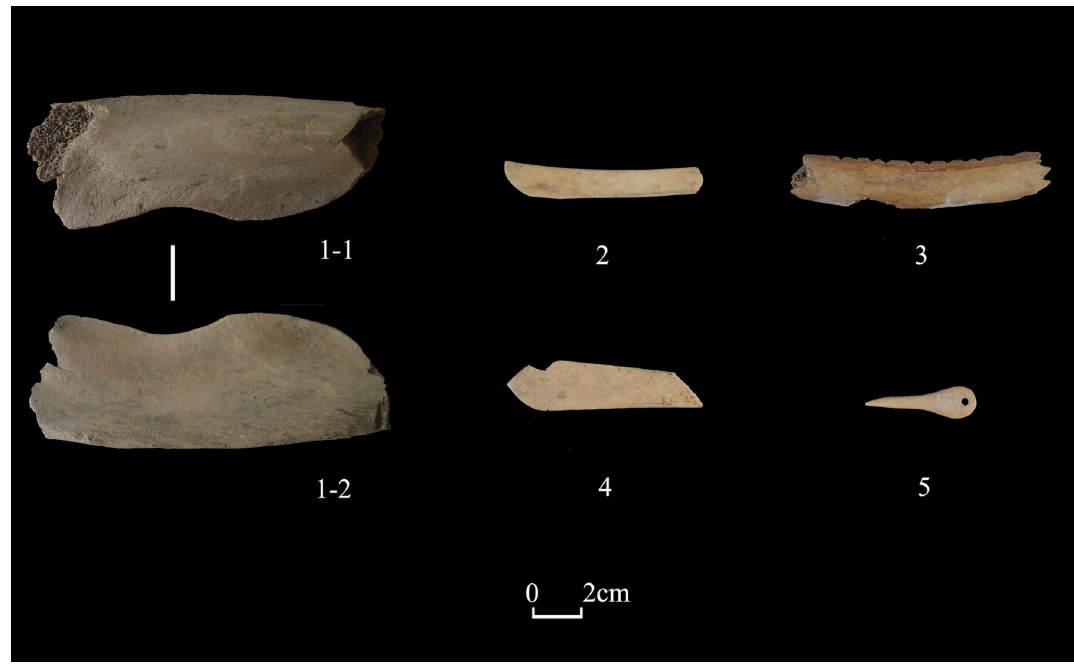
Fig 7. Examples of bone tools from Shirenzigou. 1) specimen from 12XBSIIIT0720II-2 ③ ; 2) specimen from 2009HBSIIIT0822 ④ ; 3) specimen from 2010HBSIIIT0819IV ① ; 4) specimen from 2010HBSIIIT0720I ② ; 5) specimen from 2011XBSIIIDM4.